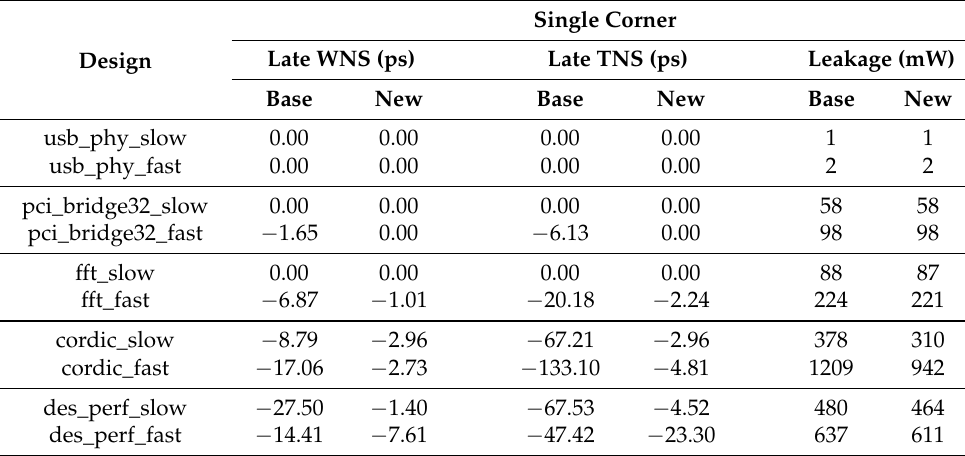
Table 3. Timing and leakage power of all designs under single corner with gate size selection restriction without (Base) and with (New) proposed LM